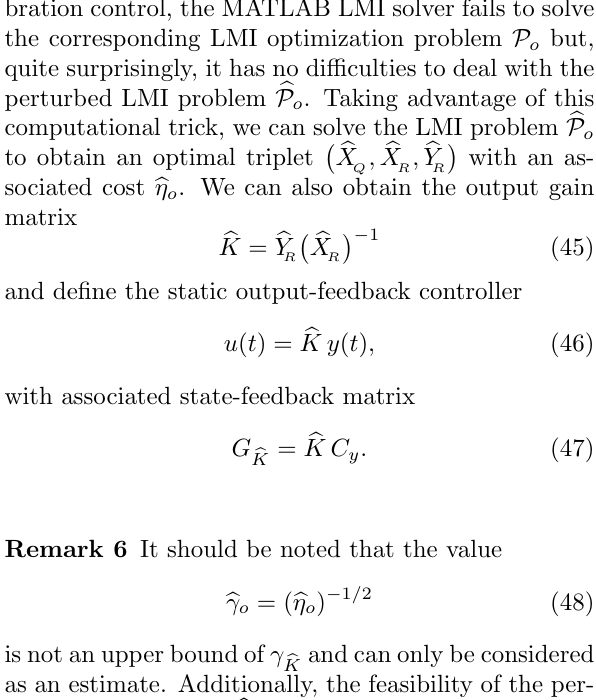
Figure 2: Perturbed linear matrix inequality for static output-feedback H ∞ controller